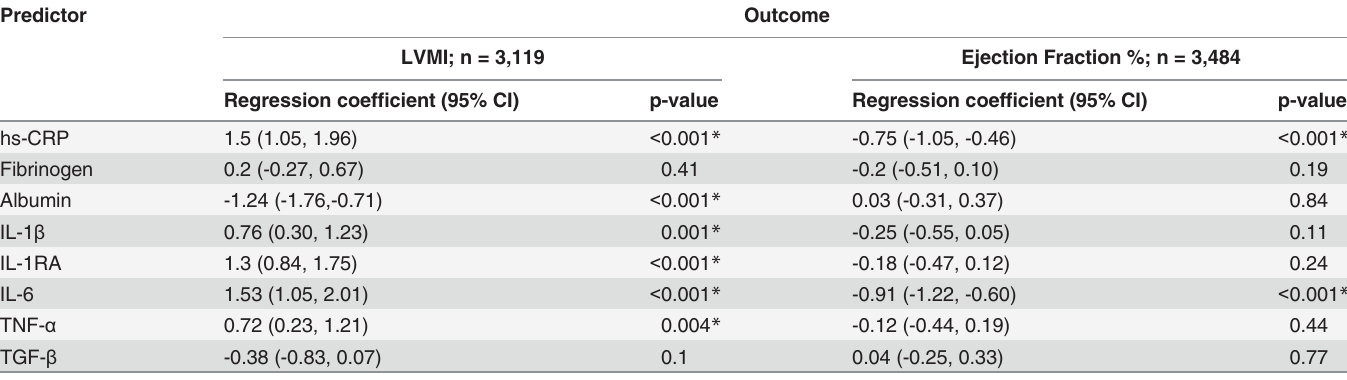
Table 2. Adjusted linear regression models showing the association of inflammatory biomarkers with LVMI and ejection fraction. Predictor Outcome LVMI; n = 3,119 Ejection Fraction %; n = 3,484 Regression coef fi cient (95% CI) p-value Regression coef fi cient (95% CI) p-value hs-CRP